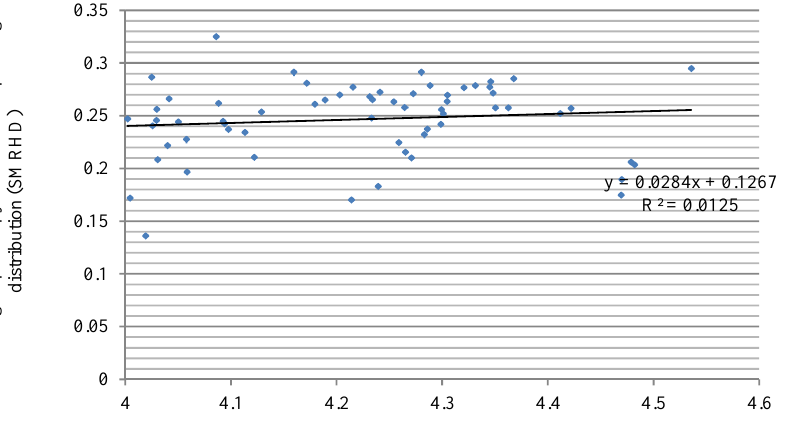
Figure 7. Linear regression for link "the absolute size of consumer spending — a measure of diversity of consumer spending (within-group entropy for SMRHD) for 63 countries with highest household spending